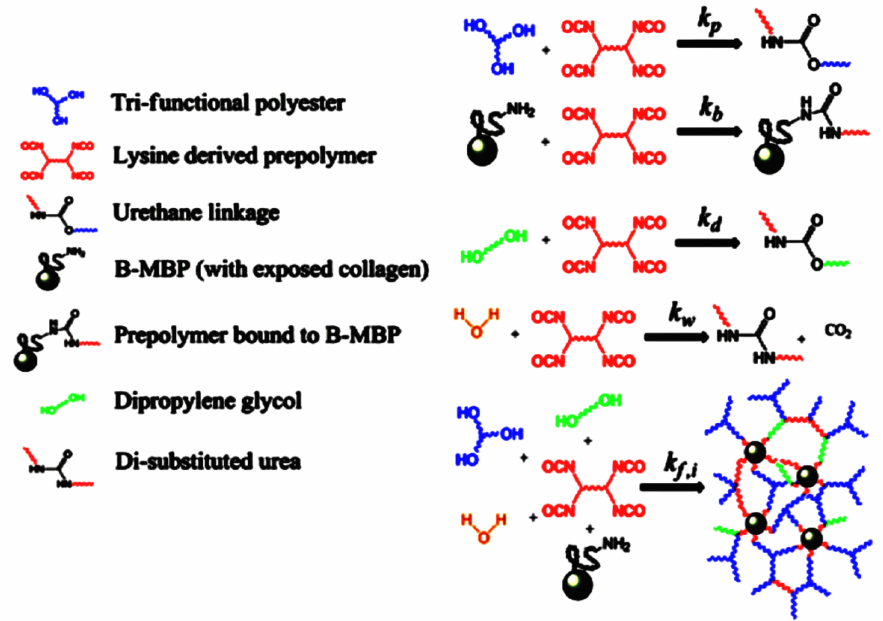
Figure 10. Chemical reactions present in the injectable PUR biocomposite. Reprinted from [130] with permission from